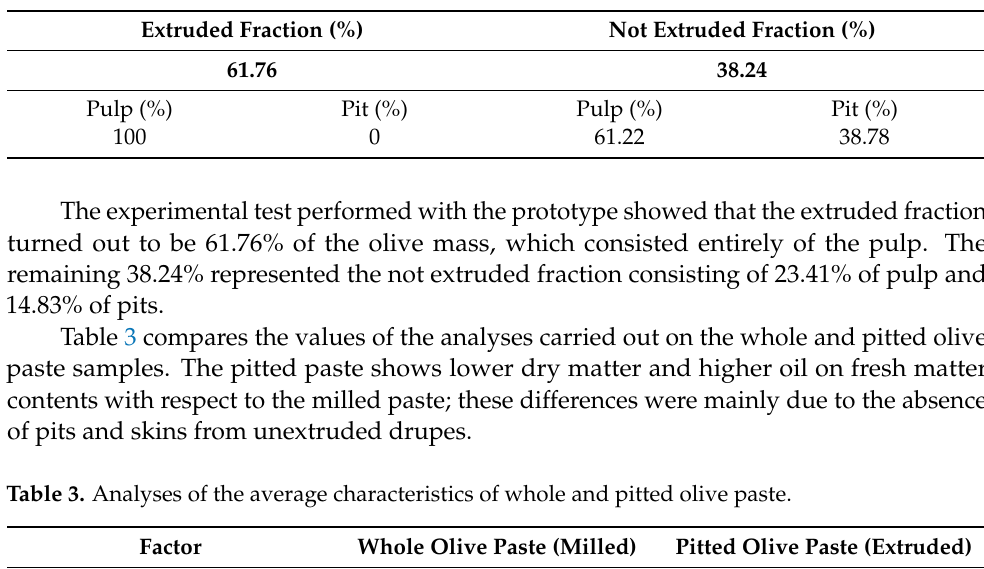
Table 2. Output of olives fraction obtained with the prototype.